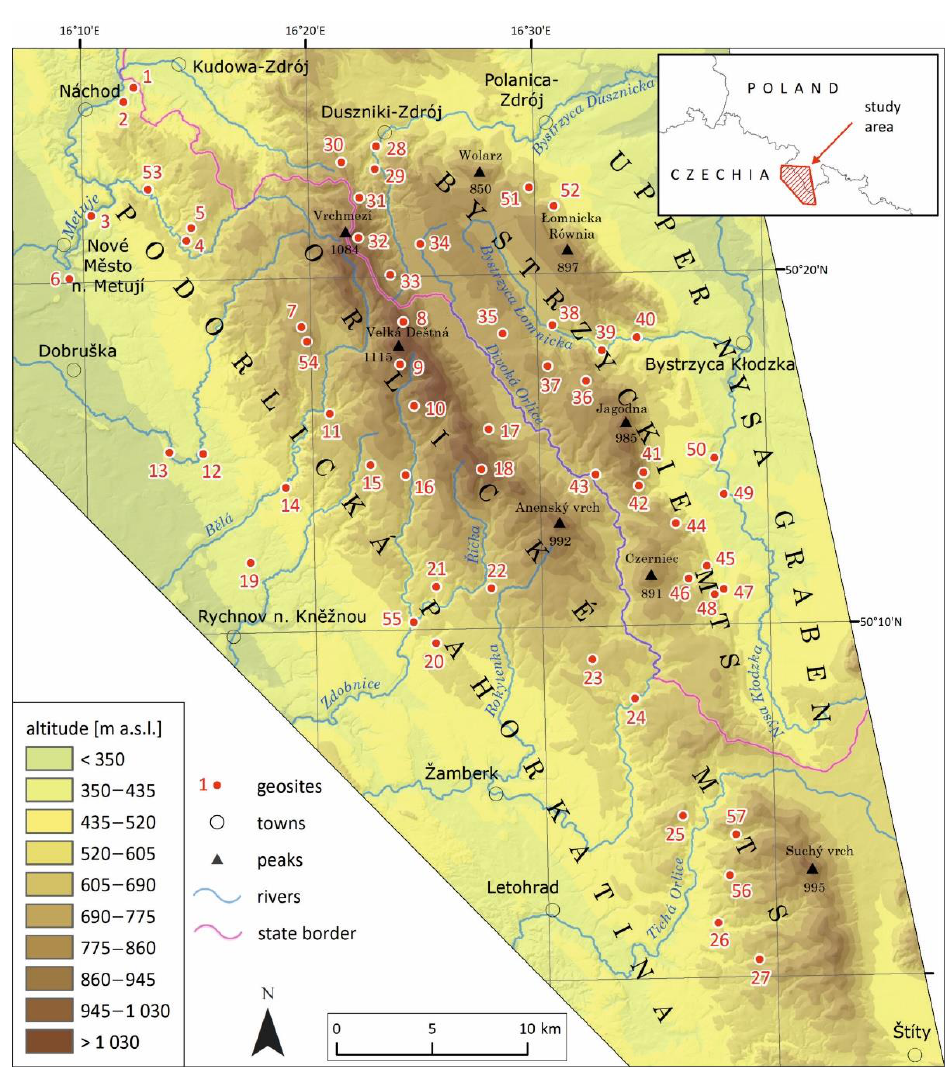
Figure 1. Hypsometry of the Orlické–Bystrzyckie Mountains Block and location of geosites (names of geosites no. 1 to 50 in Tables 1 and 2. Remaining geosites: 51—Kamienna Góra,